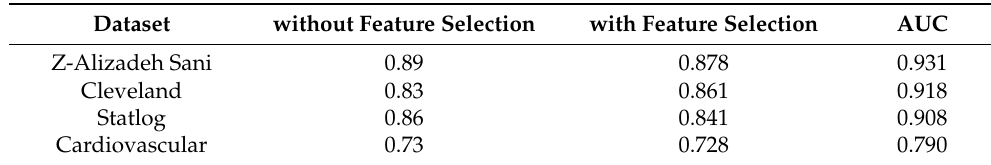
Table 6. Performance accuracy using the LightGBM